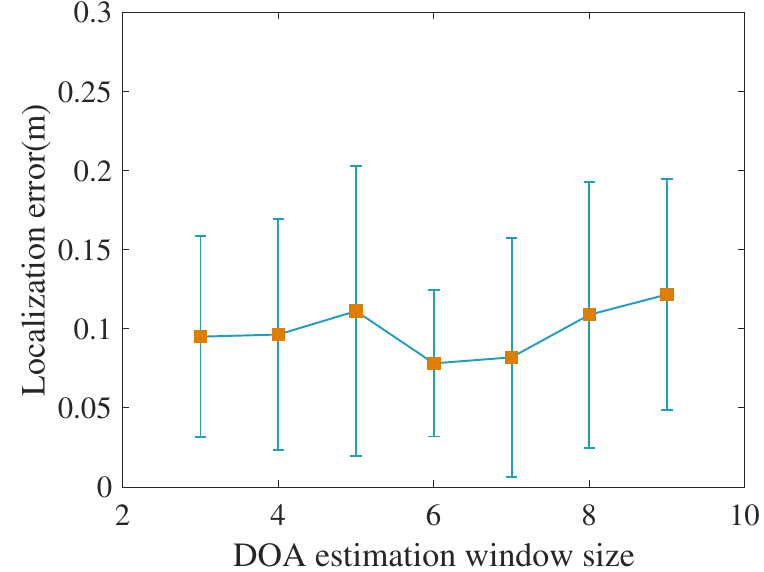
Figure 7. DOA estimation window size